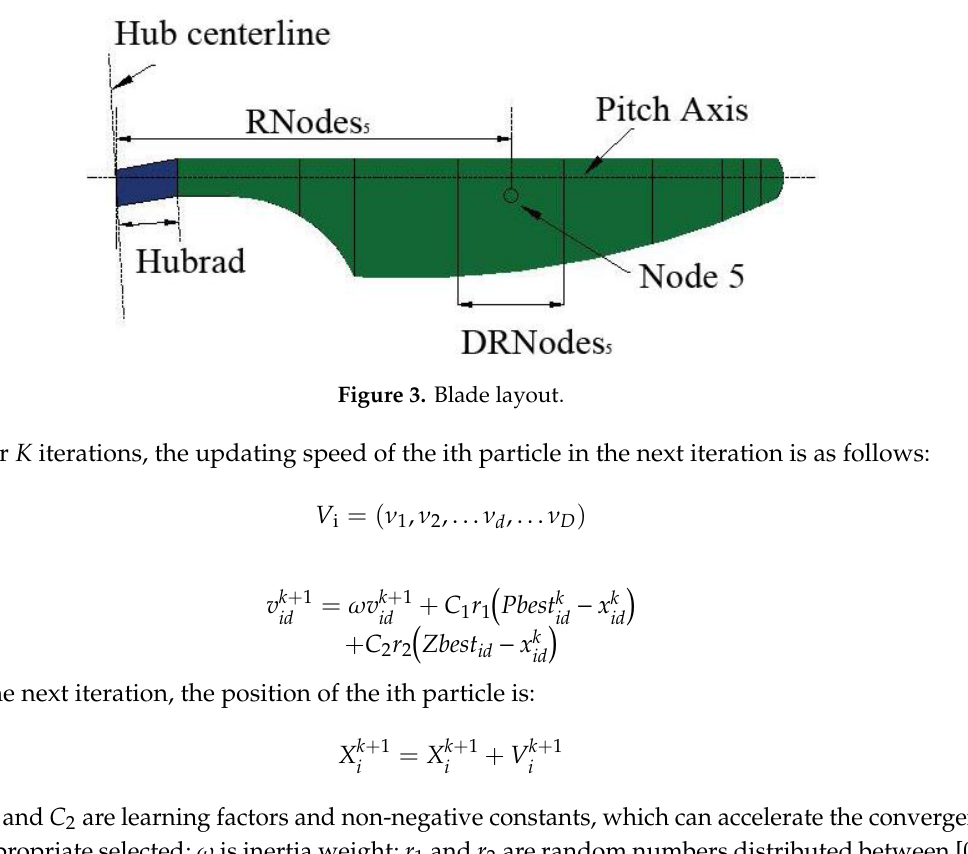
Figure 2. Blade structure of NREL 5 MW wind turbine.